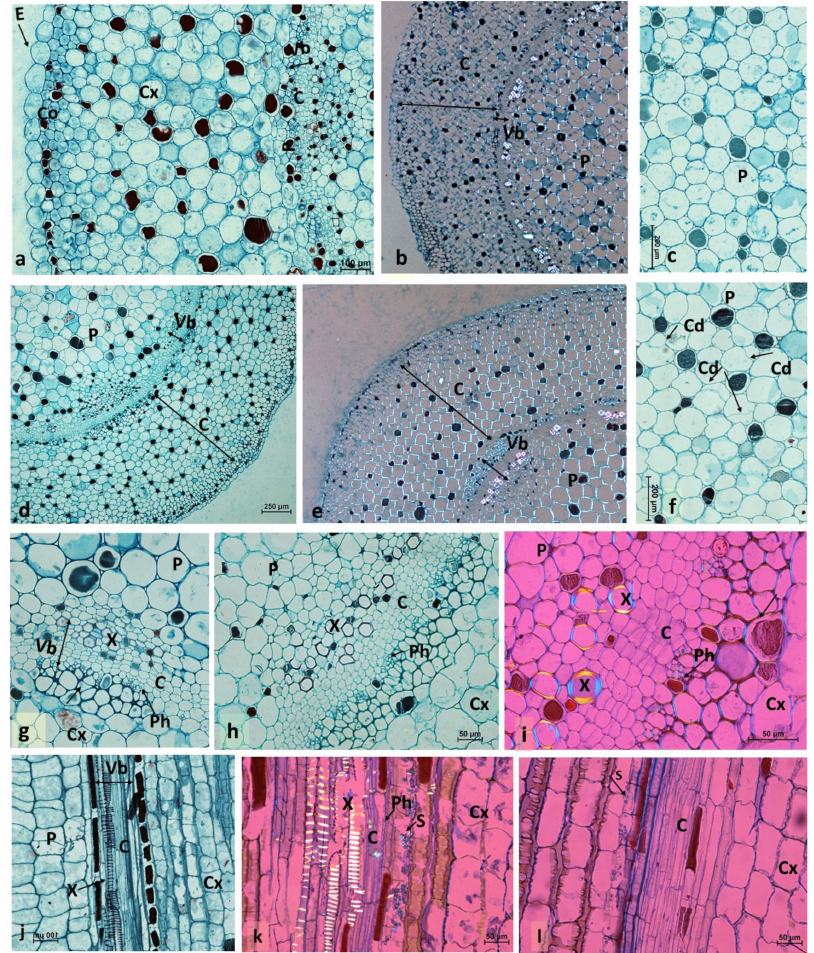
Figure 2. Anatomical details in the middle of B. calycinum internode. ( a – c ): Cross-section of the Scheme 0. w/w ). ( d ): Cross-section under LM. ( e ): Cross-section under LMP. ( f ): Fragment of the pith in LM. ( g – i ): Details of vascu- lar tissue on the cross-section of the control stem under LM ( g ) and LMP ( h ), and of stem swelling induced by NPA application under LMP ( i ). ( j – l ): Details of vascular tissue on the longitudinal section of the control stem under LM ( j ) and LMP ( k ), and of conspicuous local stem swelling induced by NPA under LMP ( l ). C: cambium; Cd: cell division; Co: collenchyma; Cx: cortex; E: epidermis; P: pith; Ph: phloem; S: starch; VB; vascular tissues; X: